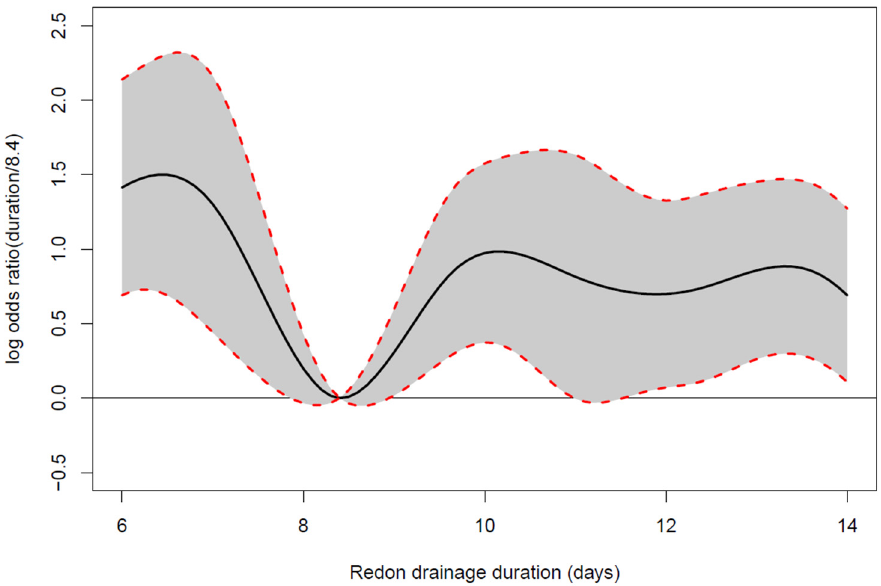
Figure 4. Estimated log odds ratios comparing the probability for further seroma evacuation at any other day-to-drain removal (drain indwelling time) vs. the time of drain removal at 8.4 days with pointwise 95% confidence intervals. The odds ratio of 0 implicates the lowest possible probability of developing a seroma. Removal before and after day 8.4 was associated with higher log odds ratios for seroma evacuation (black solid line).